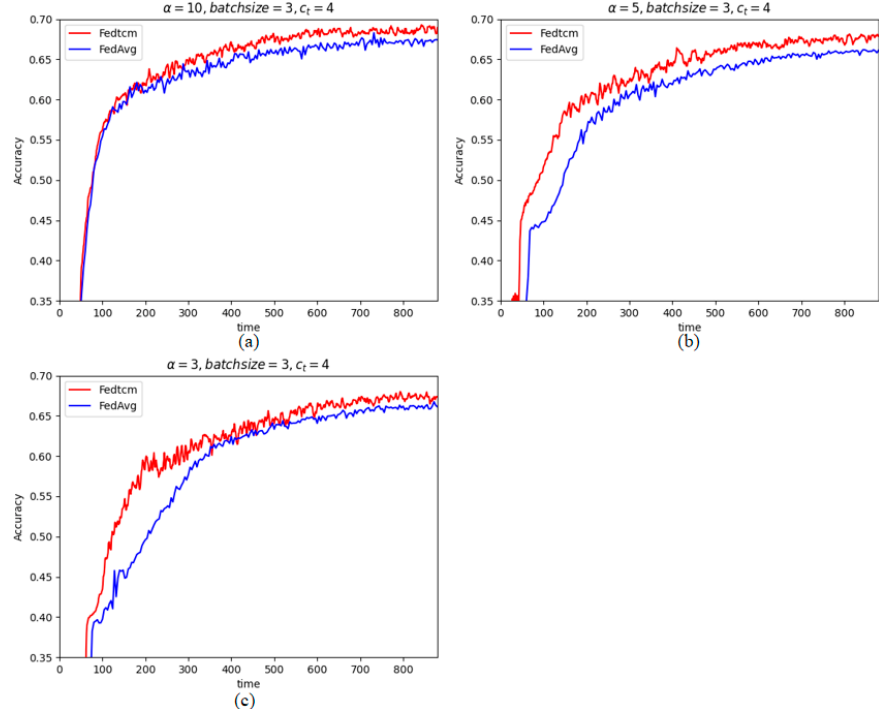
Figure 7. Comparing FedTCM with FedAvg with different α at batch size B = 3, c t = 4. ( a ) FedTCM and FedAvg are all set α = 10. ( b ) FedTCM and FedAvg are all set α = 5. ( c ) FedTCM and FedAvg are all set α = 3.